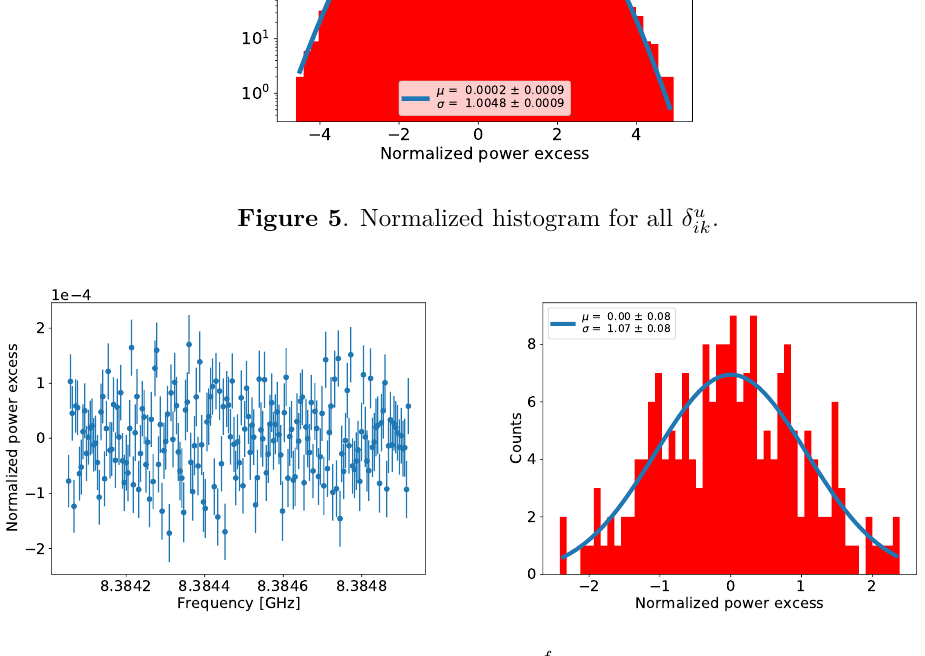
Figure 6 . Left: final Grand Unified Spectrum δ f